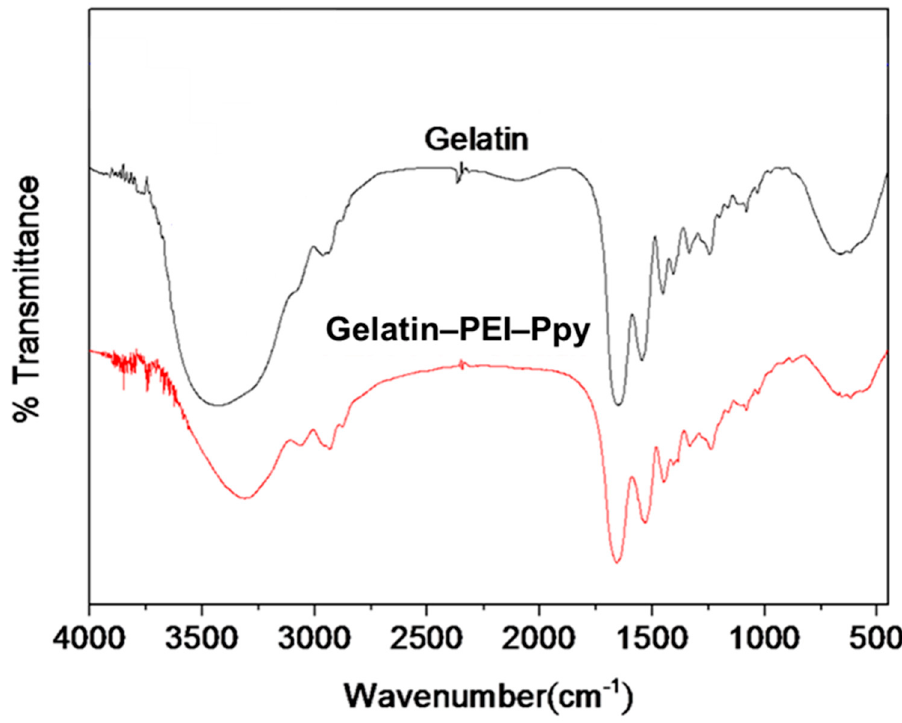
Figure 4. Results of the FTIR spectral analyses of the test samples of gelatin and the gel–PEI–Ppy NC hydrogel system.